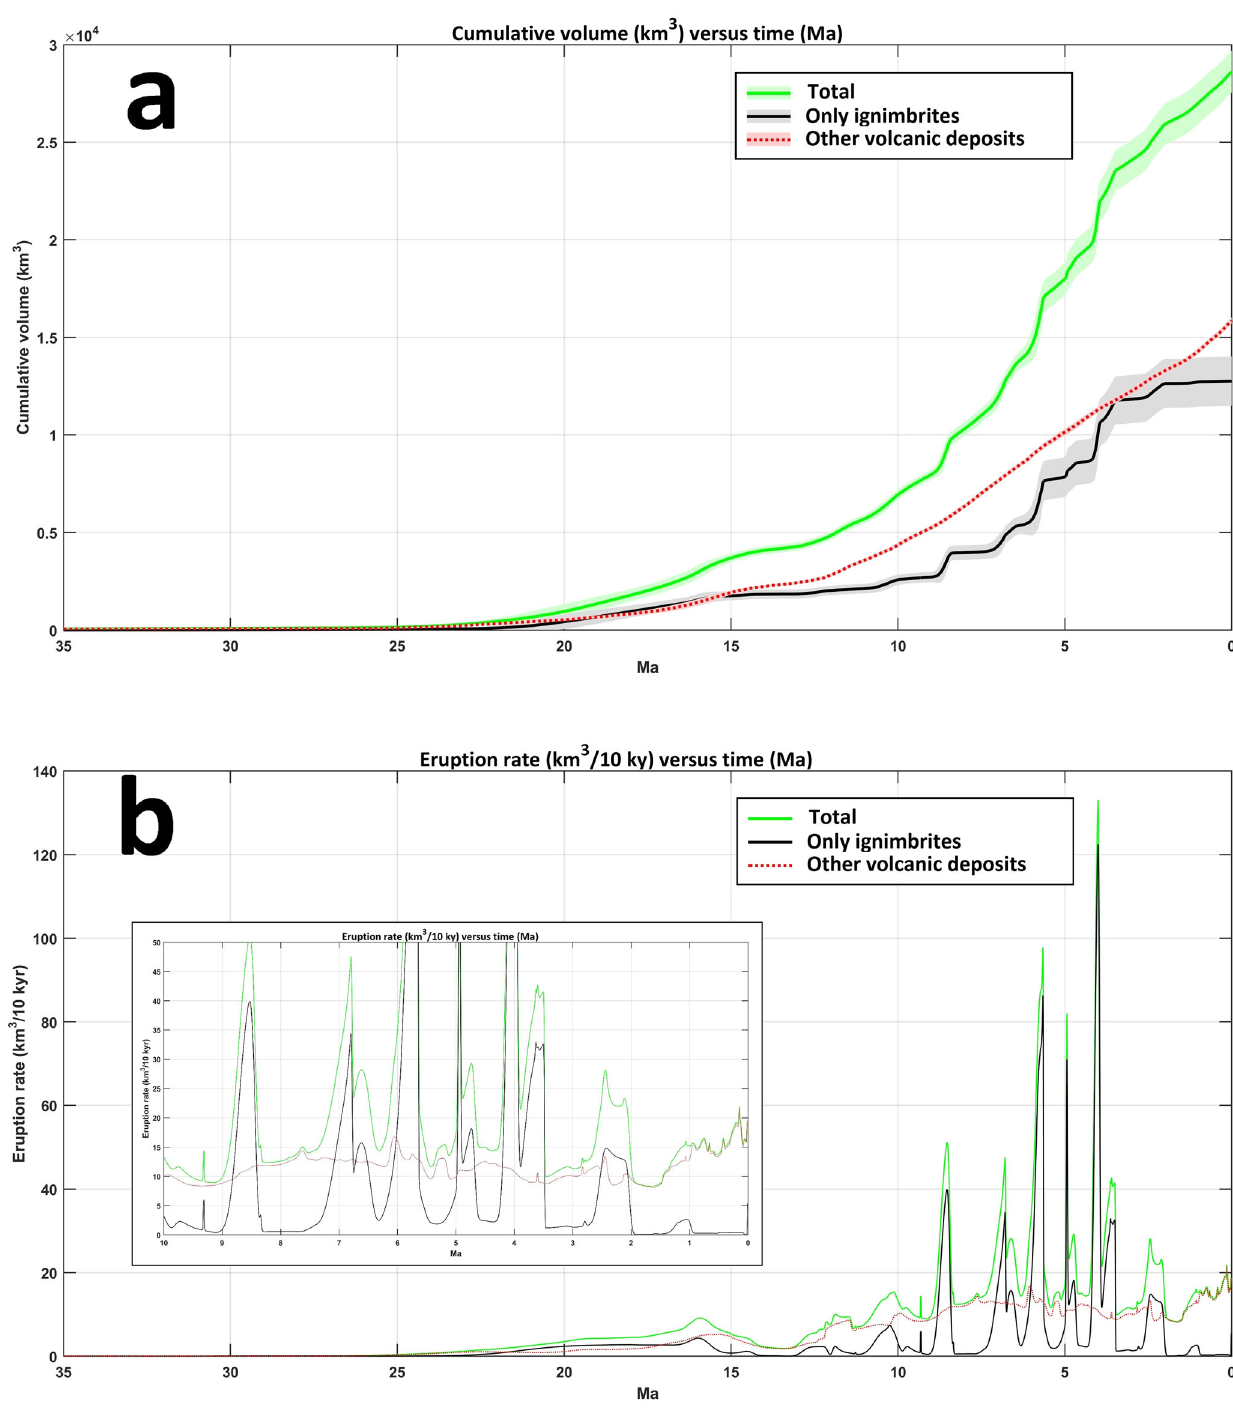
Fig. 2 Results of the volumetric analysis conducted for the 22.5 – 29°S segment of the Central Andes. a Cumulative erupted volume (km 3 ) versus time (Ma). b Eruption rate (km 3 per 10 kyr) versus time (Ma). Data are provided for ignimbrites (black line), other volcanic deposits (red dashed line), and these two combined (green line). Uncertainty envelopes are provided in ( a ). Zoom highlighting the last 10 Myr is shown as an inset in ( b ). The fi gures including the 2 σ ranges for each plotted group are available in Supplementary Figs. 1 –